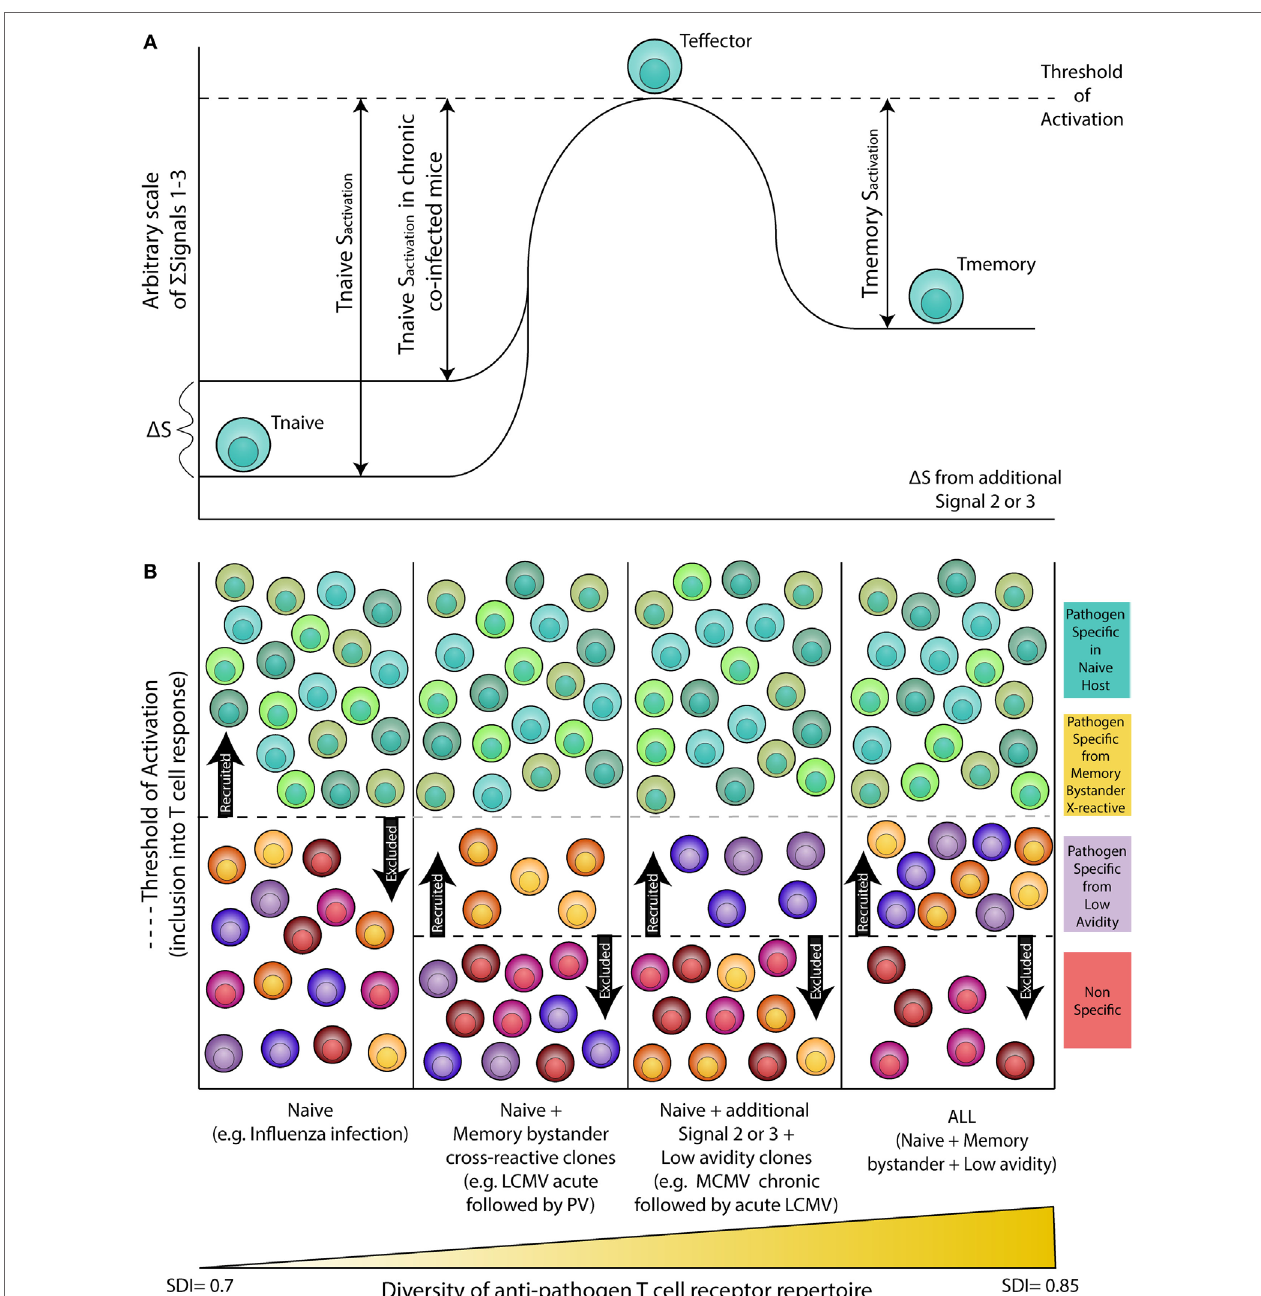
FigURe 1 | Altered threshold of CD8 T cell activation during latent and/or smoldering chronic co-infection or from memory bystander activation. (A) Three signals contribute to the activation and recruitment of naive CD8 T cells into a specific anti-pathogen response: (1) the T cell receptor (TCR), (2) co-stimulation, and (3) cytokines in the microenvironment. If the sum of these signals exceeds the threshold of activation (Tnaive s activation ), the naive CD8 T cell will be recruited into the immune response. Chronic co-infection is known to augment ( Δ S) basal cytokine levels and activation status of antigen presenting cells, thereby decreasing the signal required by naive CD8 T cells to exceed the threshold of activation (Tnaive s activation in chronic co-infected mice). In addition, memory CD8 T cells are transcriptionally poised for rapid recall of effector function upon reencounter of a pathogen, thus the amount of signal required for inclusion of a memory cell (Tmemory s activation ) is smaller than that of a naive T cell. (b) Most infectious disease studies are conducted in a naive host (far left panel), in which challenge with a pathogen will result in recruitment of pathogen-specific CD8 T cells from the naive T cell pool (blue-green T cells). In previously infected hosts, memory T cells have a lower threshold of activation and can contribute unique cross-reactive clones (yellow-orange T cells, center left panel). In addition, chronic co-infected hosts have altered signals 2 and 3 that permit the recruitment of lower avidity clones (purple T cells, center right panel). Addition of memory bystander and lower avidity clones increases the diversity of the anti-pathogen CD8 TCR repertoire. Most humans have at least one chronic infection and encounter multiple infections throughout a lifetime, thus a combination of all three scenarios (far right panel) more accurately depicts what occurs in life, and represents the most diverse population of pathogen-specific CD8 T